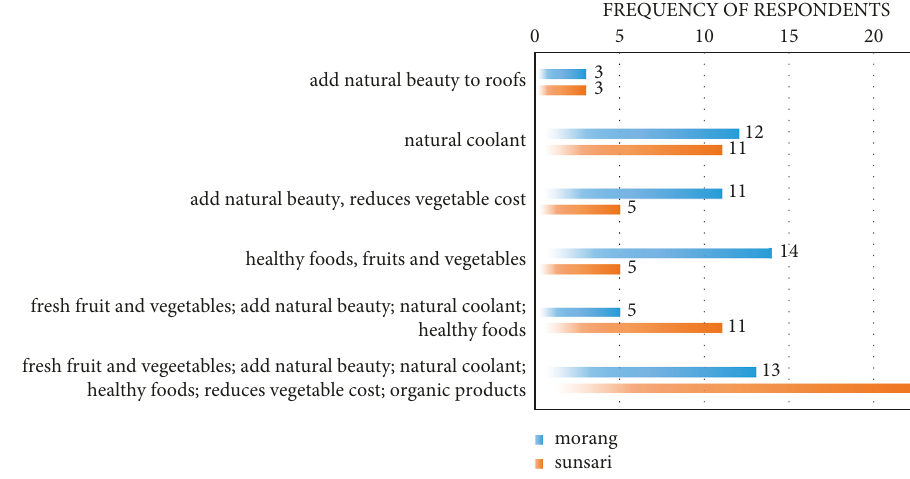
Figure 6: Benefits of rooftop gardens reported in study area.